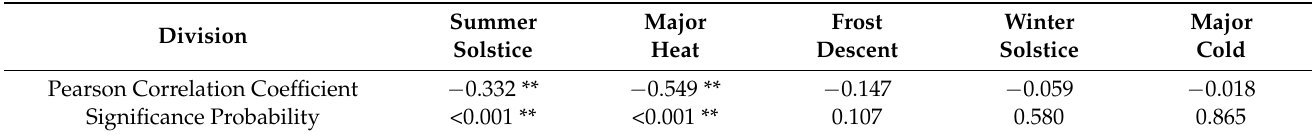
Table 6. Pearson correlation coefficient and significance